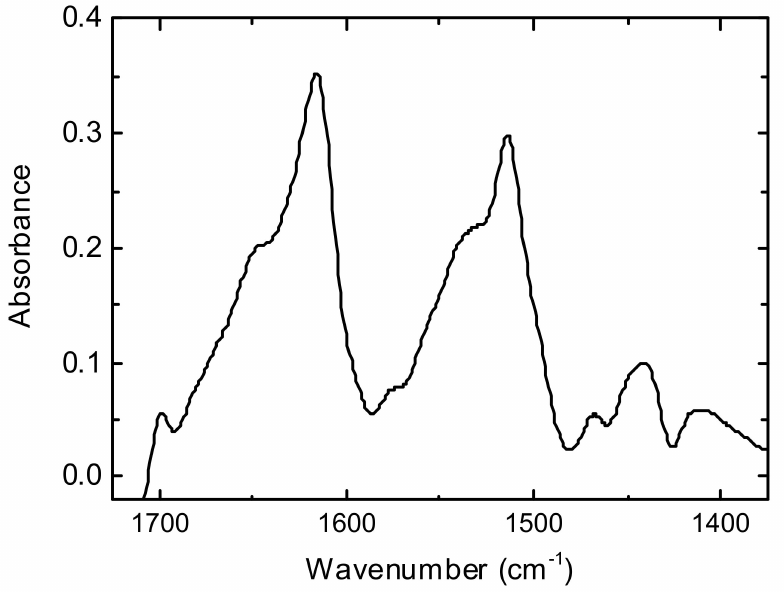
Figure 3. FTIR spectrum of original raw silk fibres of B. mori (HL = 0.08 g H 2 O per g dry matter). Amide I and amide II bands have sharp maximums at 1618 cm − 1 and 1514 cm − 1 ,